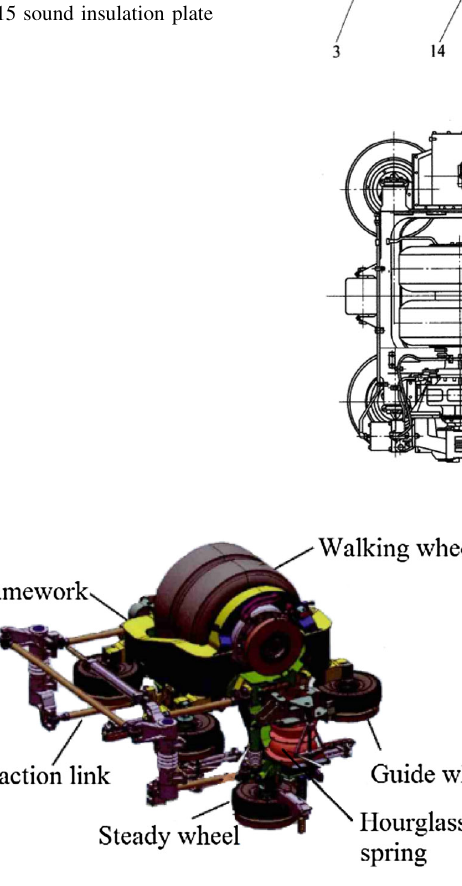
Fig. 2 Running gear of Bombardier